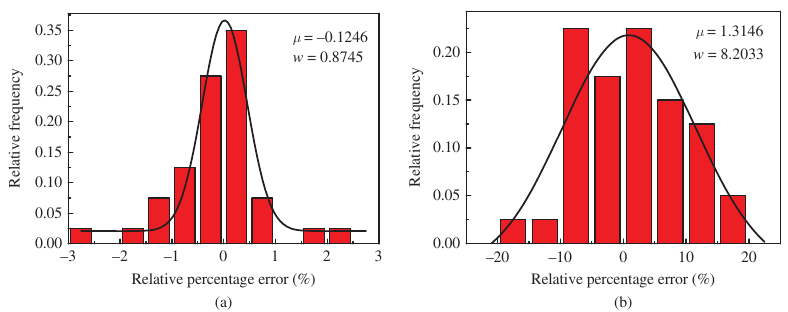
Figure 17 Distribution on relative percentage error by (a) ANN model and (b) regression model